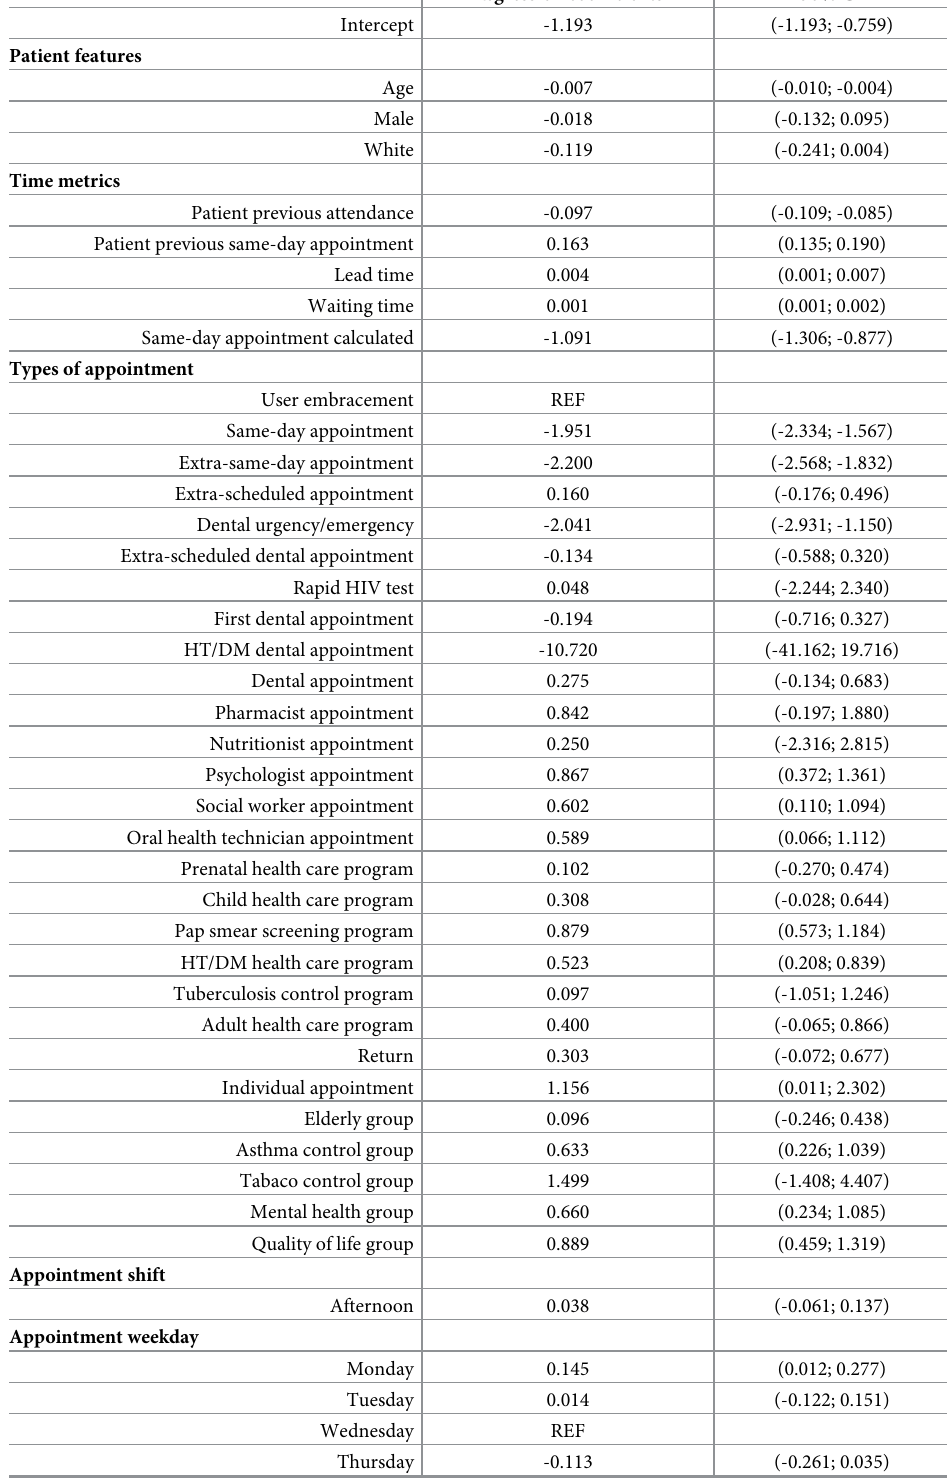
Table 2. Results of mixed-effect logistic regression of the final best